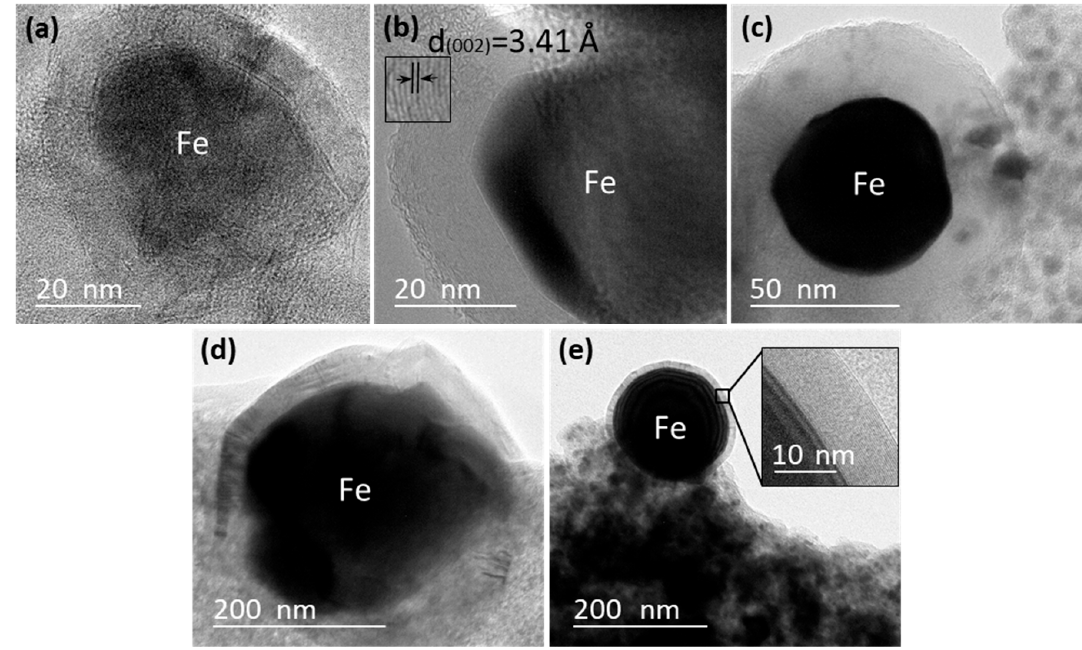
Figure 4. High-magnification TEM images of KL/Fe-700 ( a ), -750 ( b ), -800 ( c ), -900 ( d ), and -1000 ( e ) samples showed that the iron nanoparticles located along the edge of the AC matrix had 10 to 50 layers making up thick-walled graphitic-carbon shells.